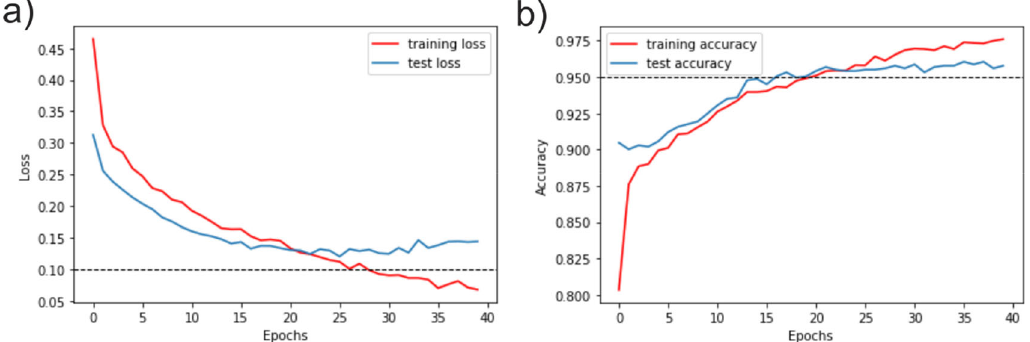
Figure 7. TensorBoard (RRID:SCR_016345) visualization of the distributed training metrics for the classifier after 30 epochs. Where x-axis represent the number of epochs and the y-axis represents the values of accuracy and